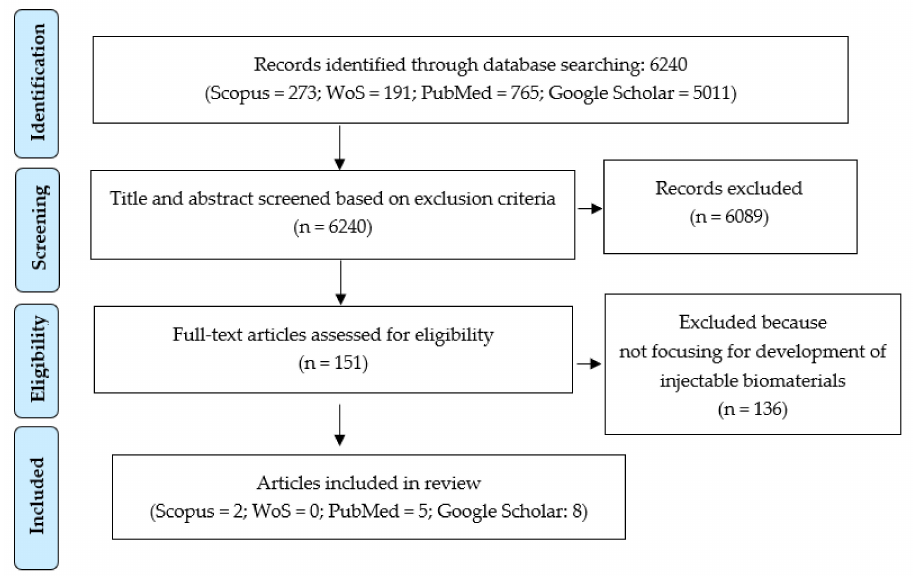
Figure 1. PRISMA flow